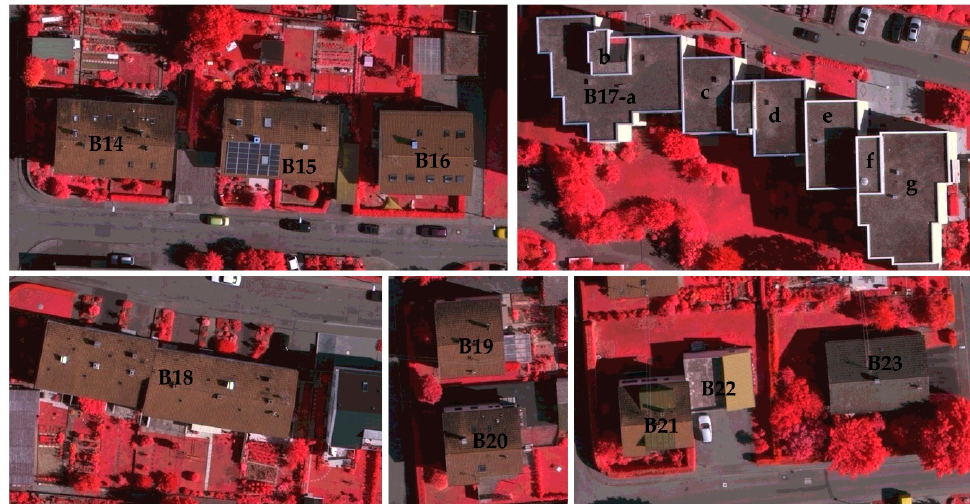
Figure 8. Buildings selected for the experiments (B14–B23) from Vaihingen / Germany dataset.